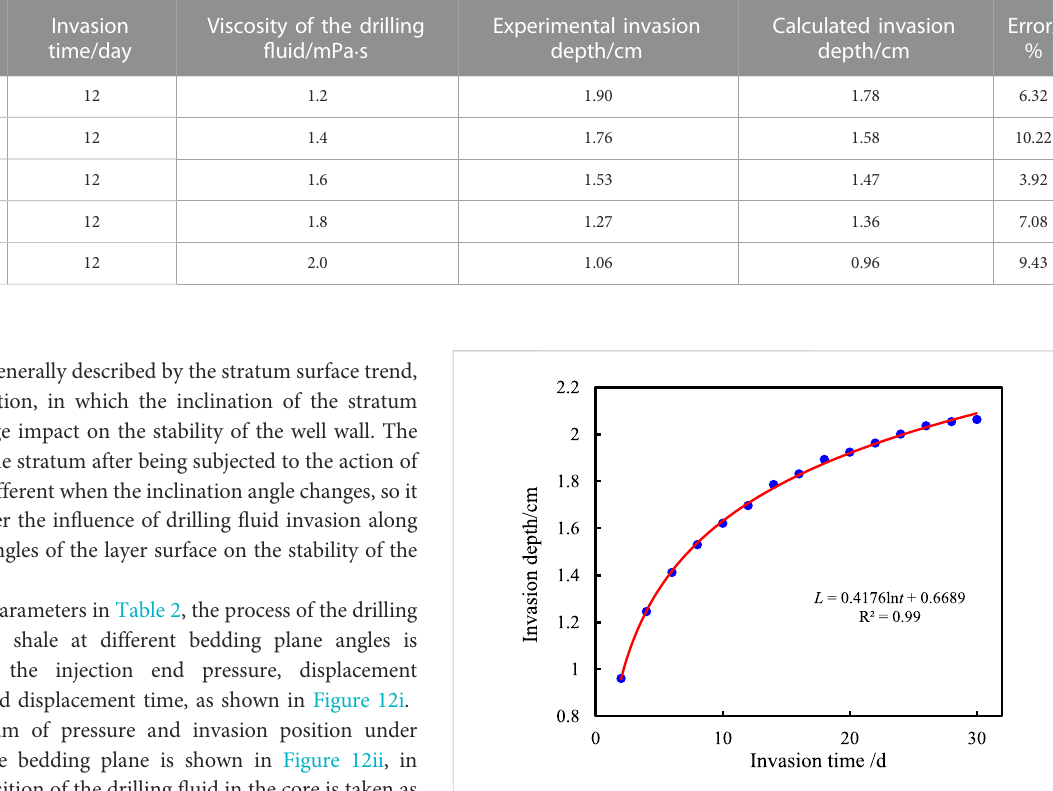
FIGURE 14 Relationship between invasion depth and invasion time of the drilling fl uid along the bedding